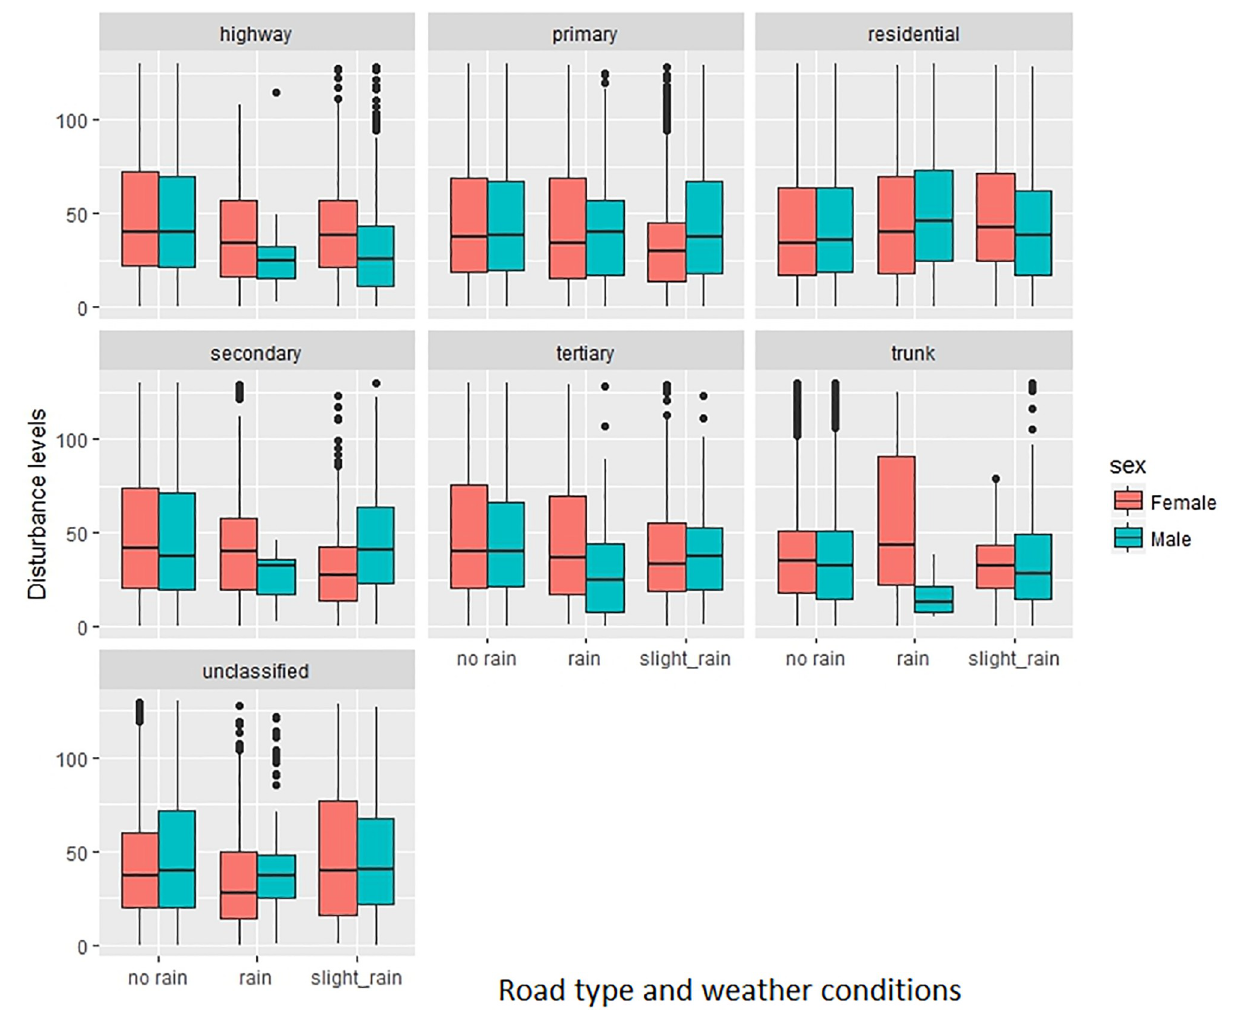
Fig 15. Individual disturbance for different road types according to different weather